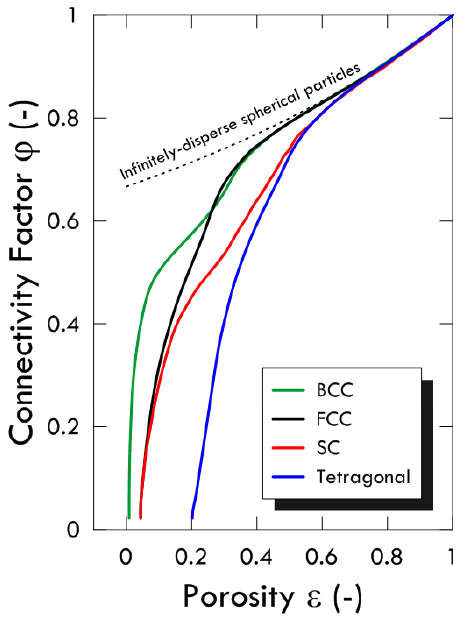
Figure 14. Connectivity Factor ϕ as a function of porosity for all the considered